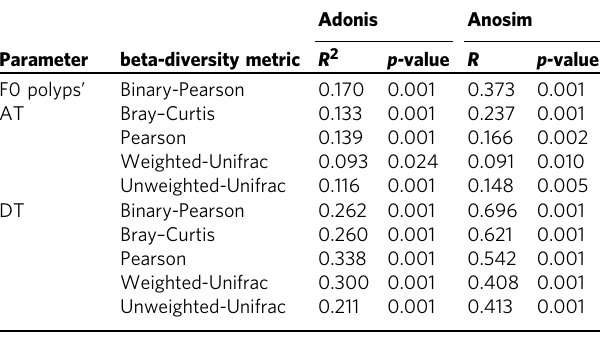
Number of permutations = 999.